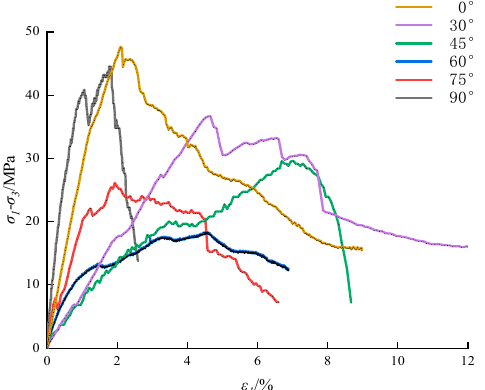
Figure 12. Deviatoric stress-axial strain curves of coal samples with different bedding angles under confining pressure of 9 MPa.